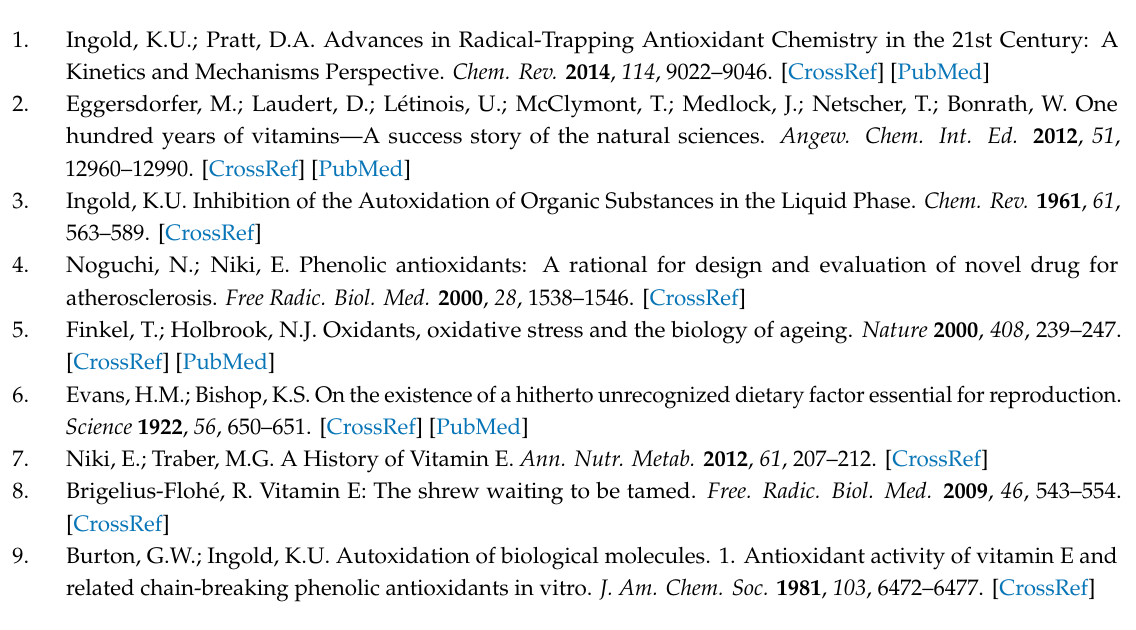
Figure 18. Role of intra-HB in δ , δ -ditocopheryl sulfide 79 and δ , δ -ditocopheryl disulfide 80.